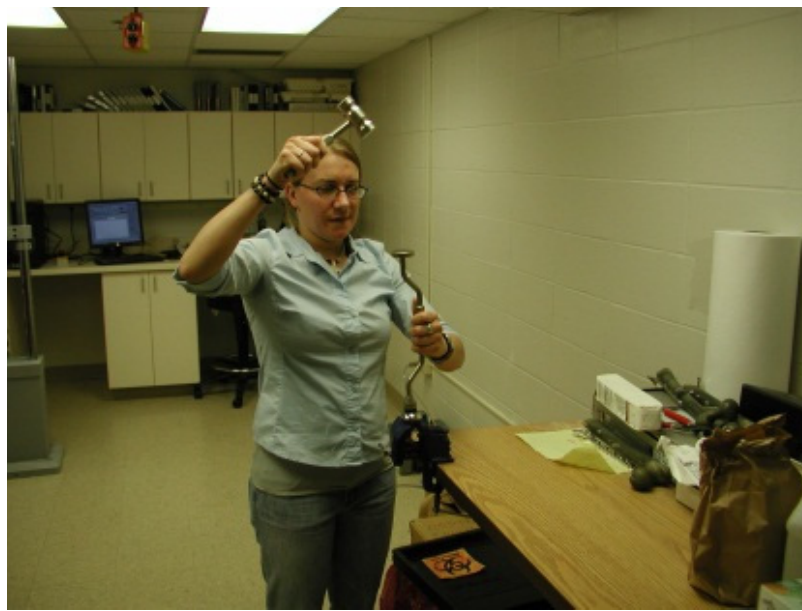
Figure A1. Experimental setup to prepare the glenohumeral implant assembly. Table A1. Summary of test parameters obtained during experimental program.